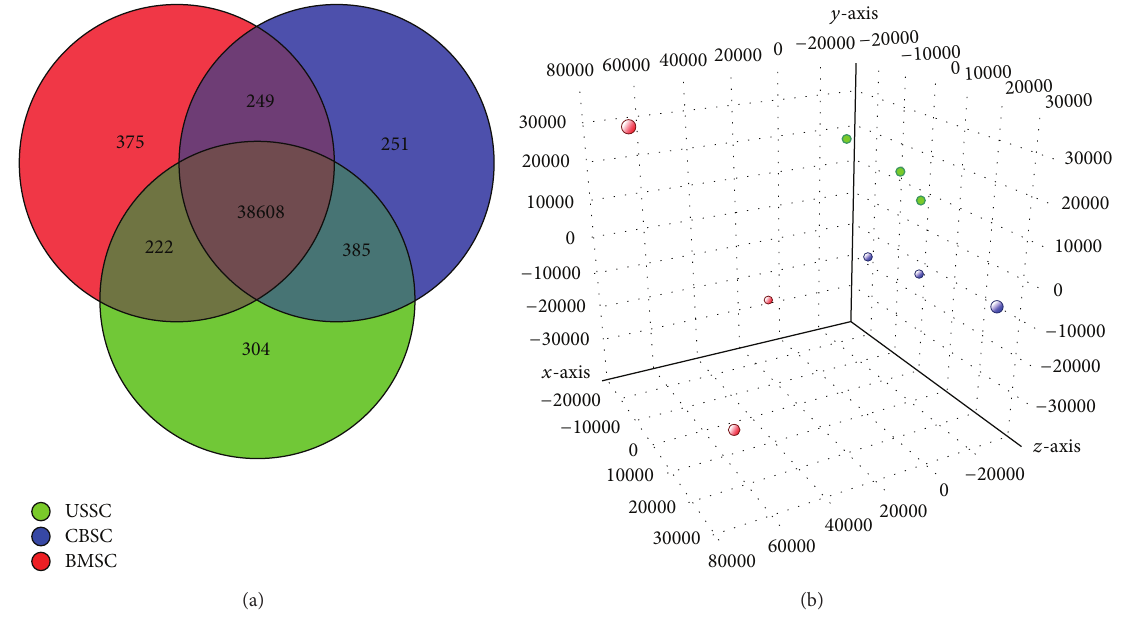
Figure 1: PrimeView human gene expression array. The gene expression of USSC (green), CBSC (blue), and BMSC (red, each in triplicate) was analyzed. (a) Venn-diagram illustrating common and unique expression of genes. The gene expression was filtered for each cell type: a probeset had to be expressed above the background (20th and 100th percentiles of the raw signal distribution) in at least two out of three replicates. This resulted in 39519 transcripts for the “group USSC,” 39493 transcripts for CBSC, and 39454 transcripts for BMSC which were compared. (b) principal component analysis (PCA) to depict the correlation of the single replicates of each cell type. Analyzed were those probesets that were expressed above the background in at least two out of three replicates in at least one out of three cell types which resulted in 40394 transcripts. The first three principal components accounted for 62.9% of the total variance (component 1 ( 𝑥 -axis): 31.6%; component 2 ( 𝑦 -axis): 18.3%; component 3 ( 𝑧 -axis): 13.0%).